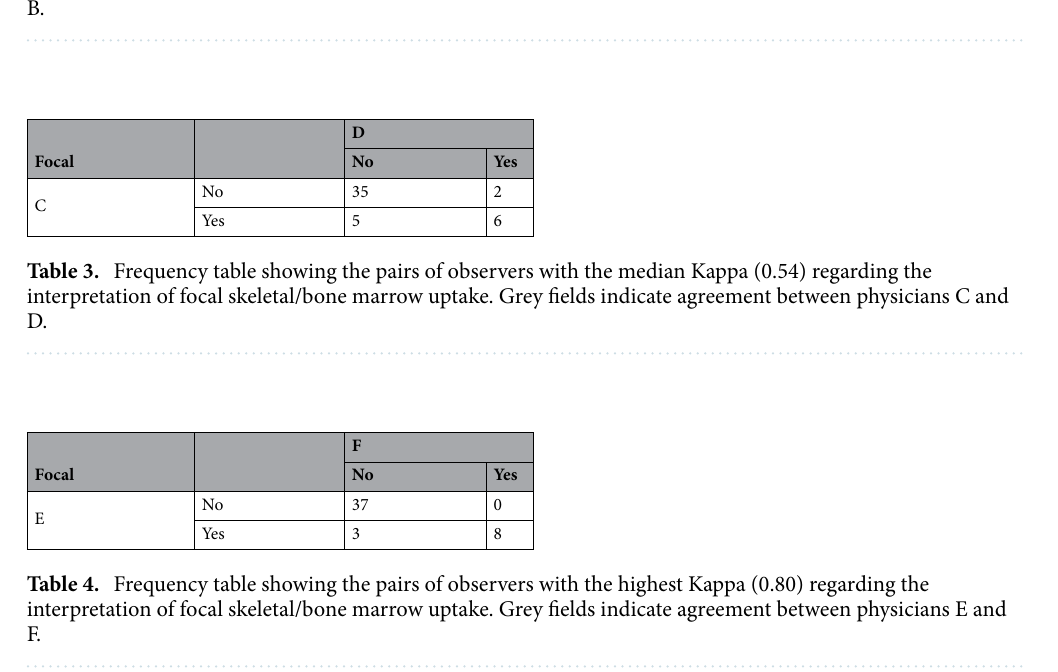
Table 2. Frequency table showing the pairs of observers with the lowest Kappa (0.25) regarding the interpretations of focal skeletal/bone marrow uptake. Grey fields indicate agreement between physicians A and B.